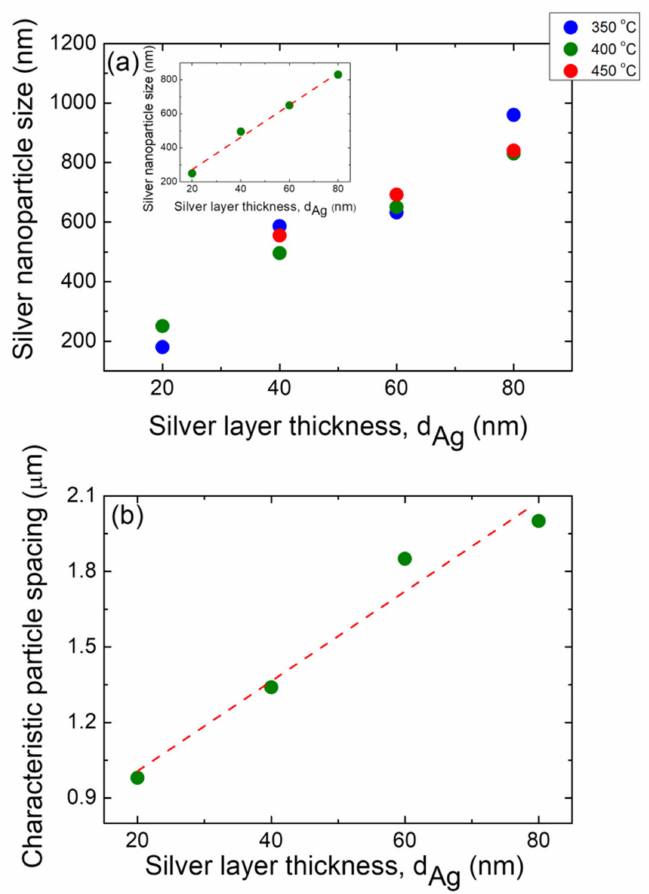
Figure 10. ( a ) Plot average size of the silver nanoparticles (D) as a function of the initial silver layer thickness, d Ag , for three different annealing temperatures: T A = 350 ◦ C (blue circles), T A = 400 ◦ C (olive green circles), and T A = 450 ◦ C (red circles). In all cases, an annealing time of t A = 1 h has been applied. Inset: plot detail for the case of the T A = 400 ◦ C case. The dashed red line corresponds to the linear fitting. ( b ) Positional correlation as a function of the initial silver layer thickness, d Ag , for samples annealed at T A = 400 ◦ C for 1 h. The dashed red line corresponds to the linear